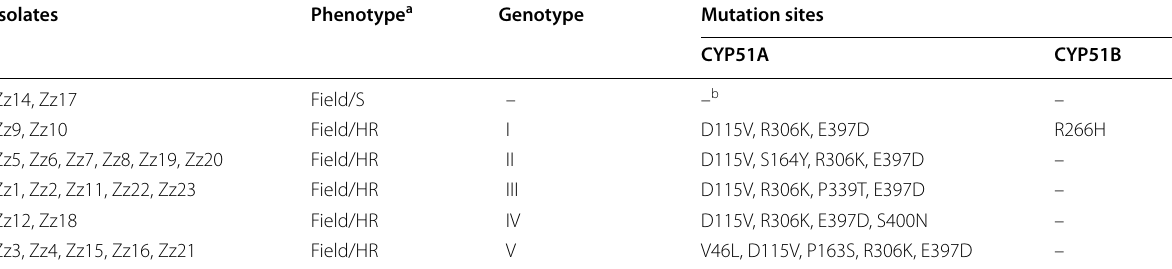
a S, sensitive; HR, high-resistant. b “–” indicates no